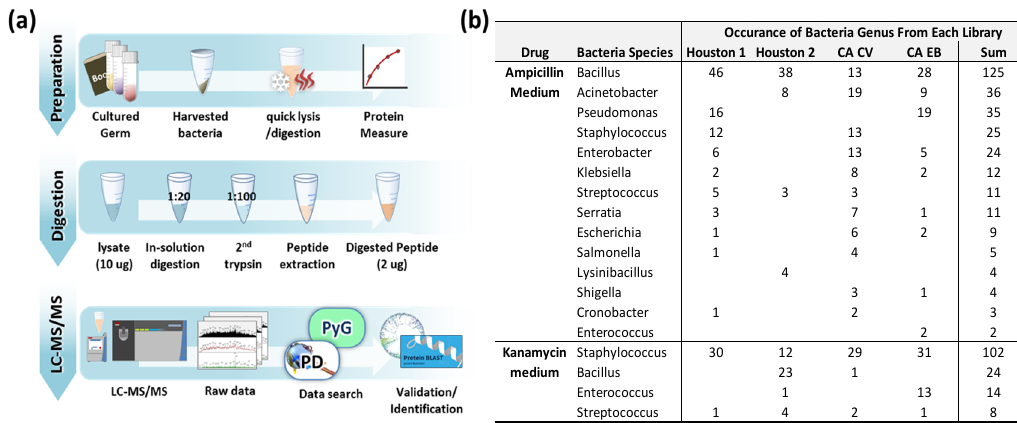
Figure 2. ( a ) Schematic illustration of workflow for identification of bacteria using LC-MS/MS. ( b ) Occurrence of bacteria in genus level from each library depends on different antibiotic medium.